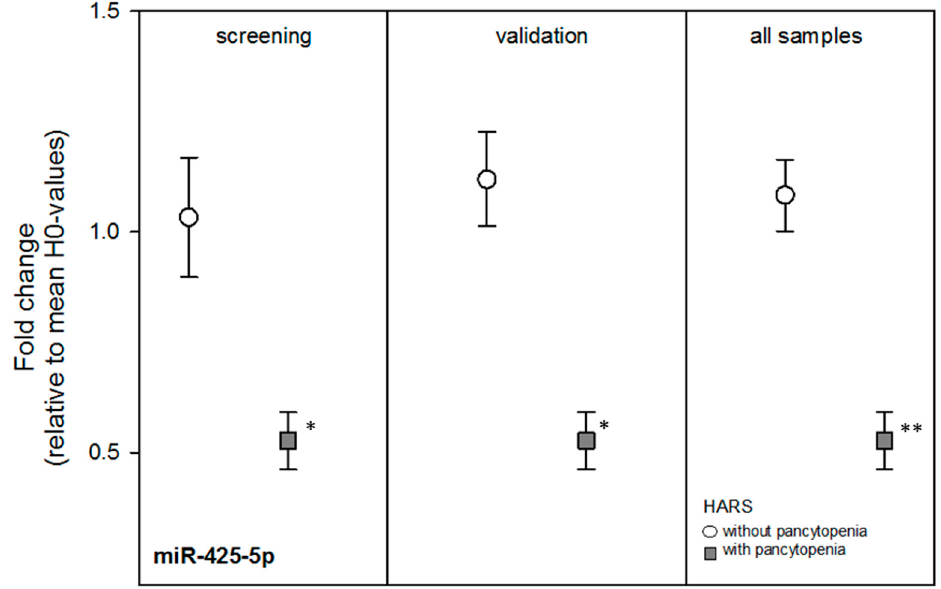
Figure 2. For graphical presentation of validated genes shown in Table 2, we plotted the mean fold change (FC) of miR-425-5p relative to the mean HARS 0 degree values (H0-values) separately for blood samples taken before irradiation in baboons developing HARS either with (squares) or without pancytopenia (circles). Error bars represent the standard error of the mean (SEM) and the numbers of blood samples examined are given in Table 2. Asterisks refer to p -values < 0.005 (*) or < 0.0005 (**). Mean FCs from the screening and the validation stage using ten and all 17 samples together are shown.